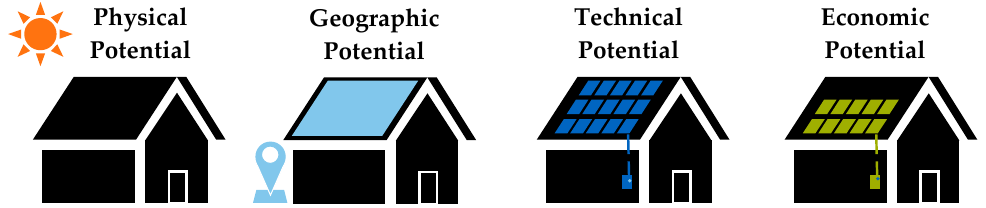
Figure 1. Visualization of the four PV potential types.